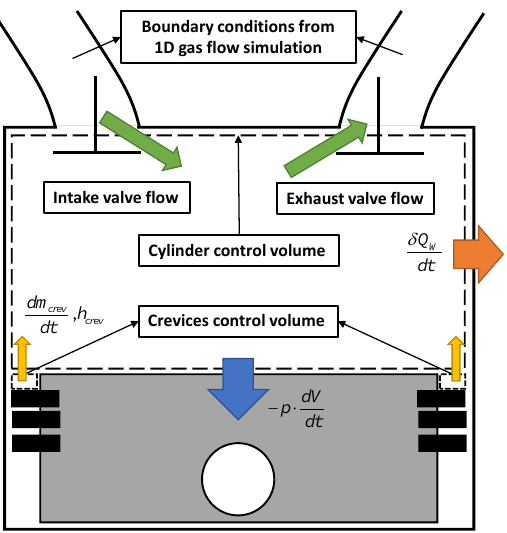
Figure 2. Control volumes and boundary conditions of the cylinder simulation.